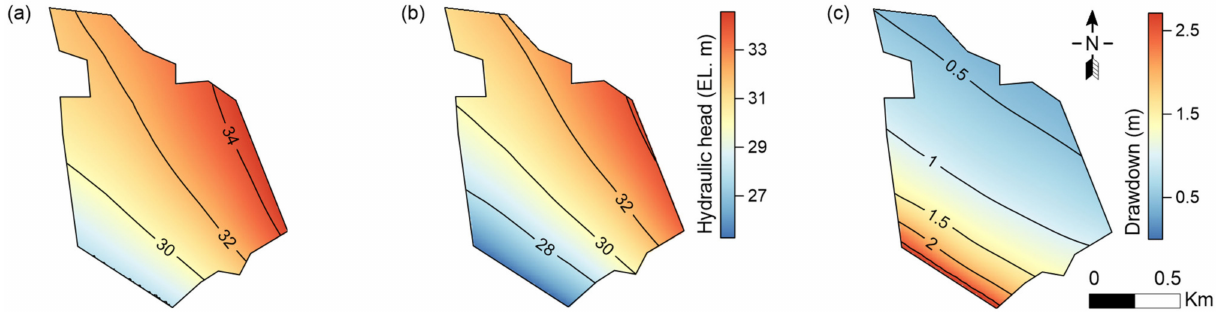
Figure 5. Changes in calculated groundwater levels due to opening of the weir during the non- seasonal pumping period, when the river level is ( a ) at the Ipo Weir management level (28 m), ( b ) at the minimum weir level (25.3 m), and ( c ) groundwater